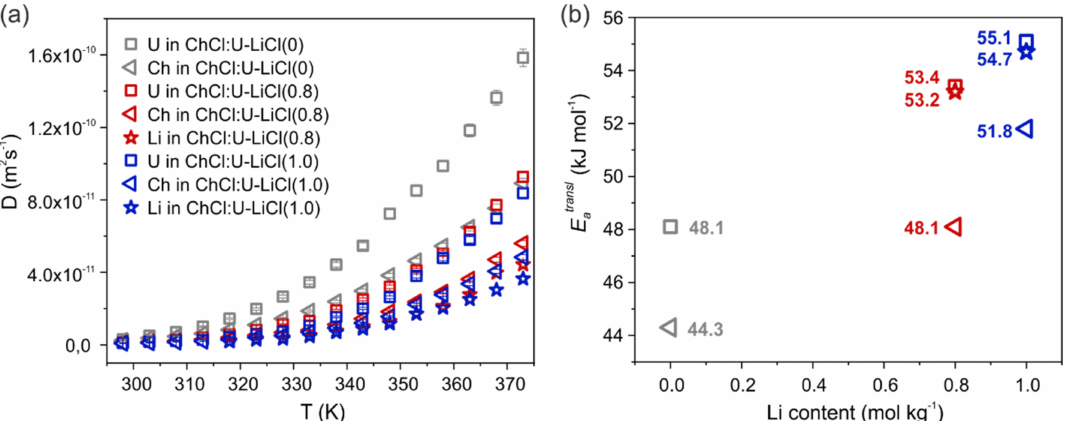
Figure 2. ( a ) Diffusion coefficients obtained for Ch (triangle), U (square) and Li (star) in the sam- ples ChCl:U-LiCl(0) (grey), ChCl:U-LiCl(0.8) (red), and ChCl:U-LiCl(1.0) (blue), as a function of temperature. The self-diffusion of CH 3 is used here as representative for Ch, all cholinium protons exhibiting the same diffusivity. Maximum errors are estimated to be 3% for 1 H and 5% for 7 Li. ( b ) Apparent translational activation energy E transl a obtained from the Arrhenius plots of diffusion data of for Ch (triangle), U (square) and Li (star), as a function of the LiCl content (0 mol/kg = grey, 0.8 mol/kg = red, and 1.0 mol/kg =